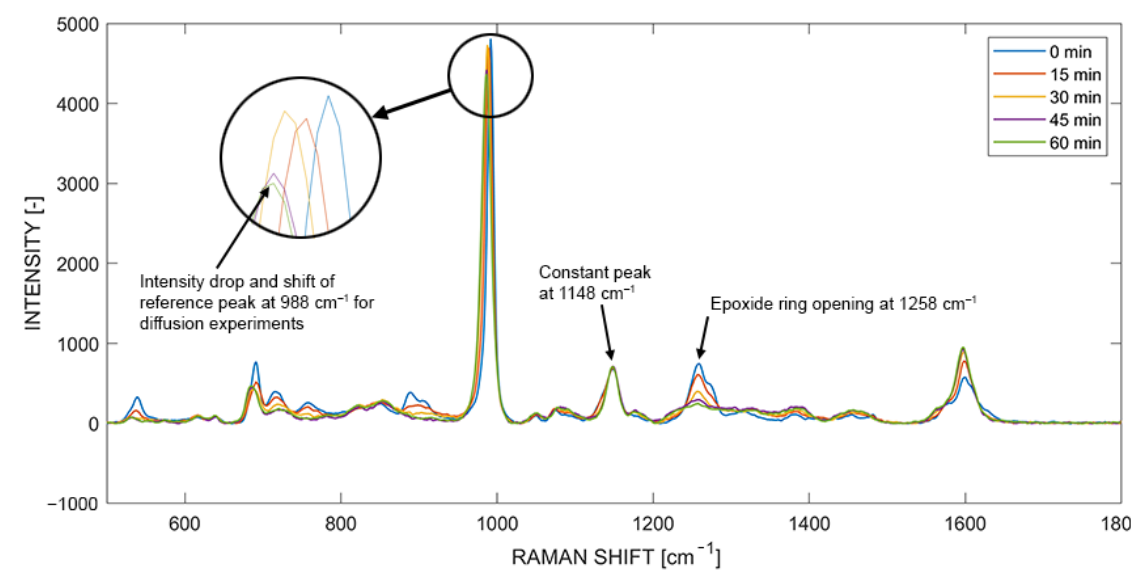
Figure 12. In situ Raman spectra featuring the reactive and reference peaks during curing at 180